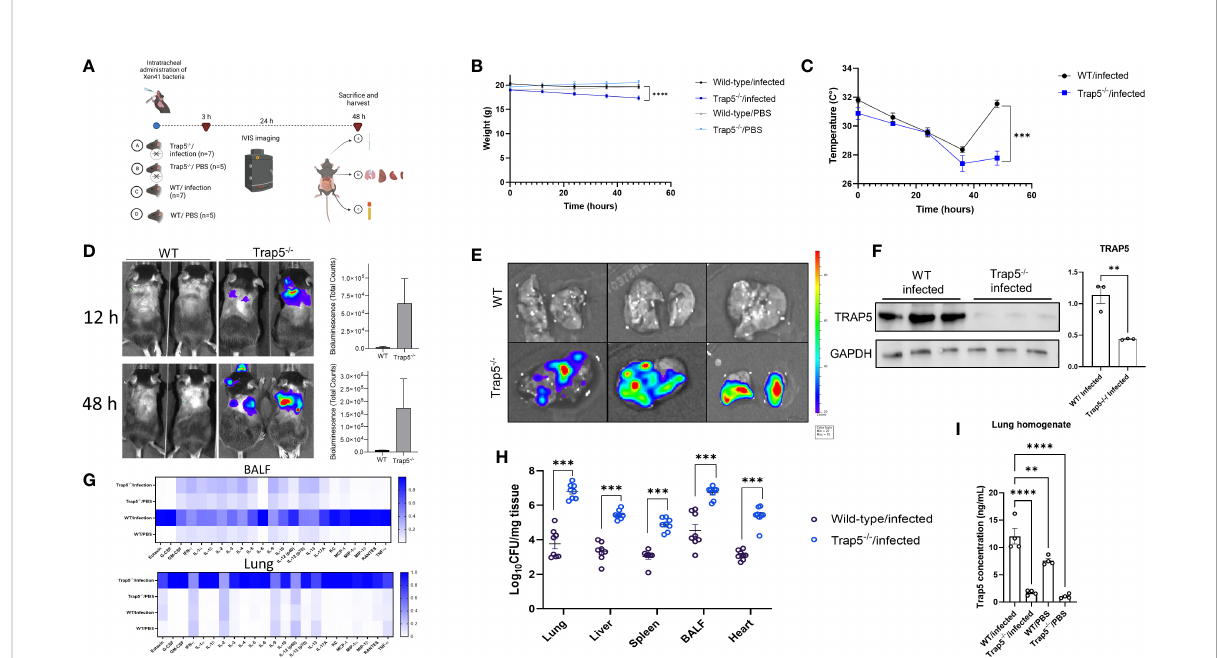
FIGURE 2 Immune cell recruitment following bacterial infection is impaired in Trap5 knockout mice. (A) C57BL6/J mice (both Trap5 -/- and wild-type (WT)) were infected with Xen41 bioluminescent bacteria for 48h. (B, C) Murine weight and surface body temperature was measured over the